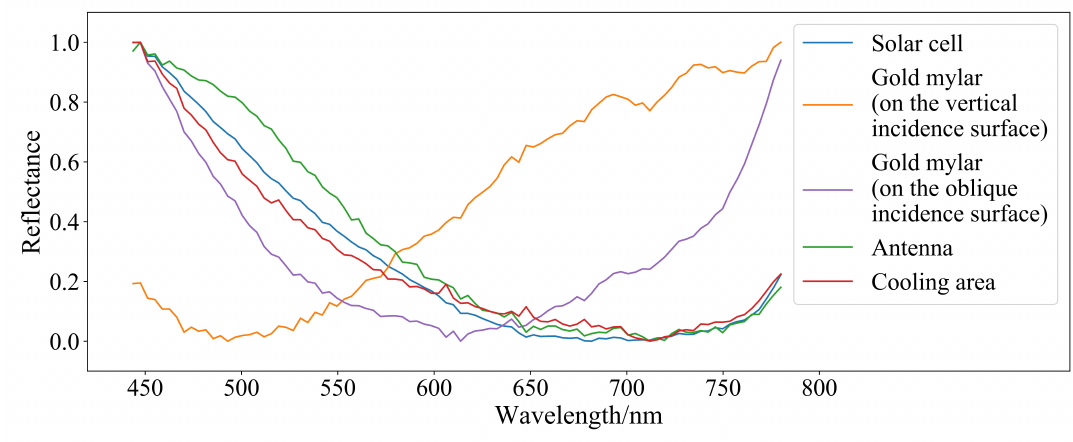
Figure 4. Normalized materials’ spectra in the hyperspectral image of the space target model.